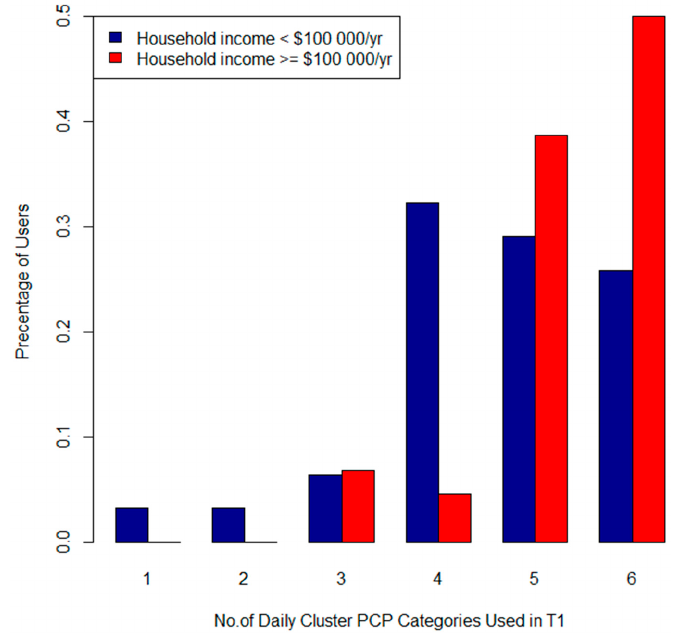
Figure 9. Total number of Daily PCPs (Cluster 2) used per participant by income category in T1.